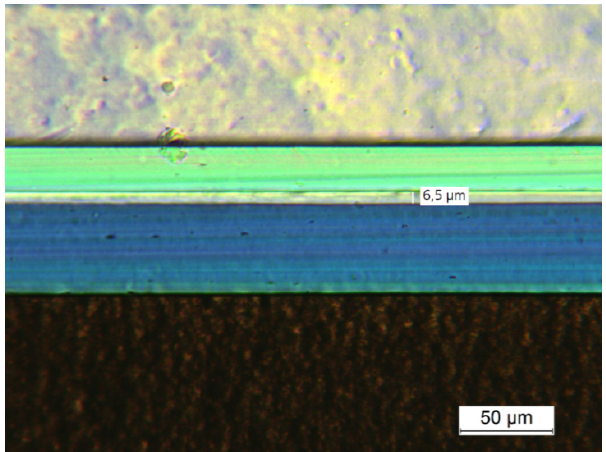
Figure 7. Microtome cut of the produced PET–PE laminate. The green material layer represents the PET film, the blue one the LDPE film.